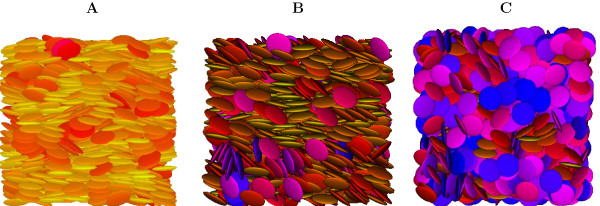
HT-AT, MC Snapshots. Snapshots from MC simulations of system Q2 at T* = 0.6 (A), T* = 0.8 (B), T* = 1.4 (C). The orientation of the molecules, with respect to the director, is rendered using a color coding ranging from yellow (parallel) to blue (perpendicular).